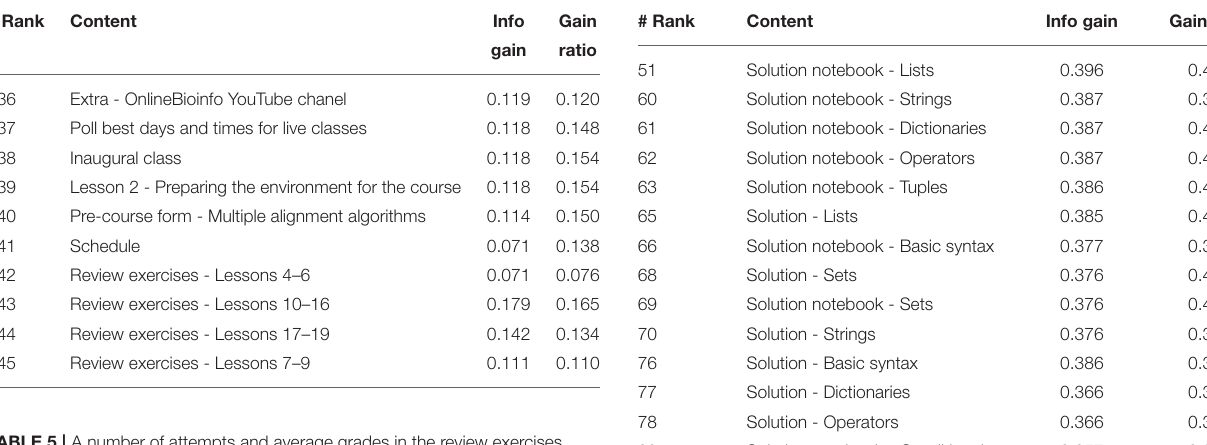
TABLE 5 | A number of attempts and average grades in the review exercises.